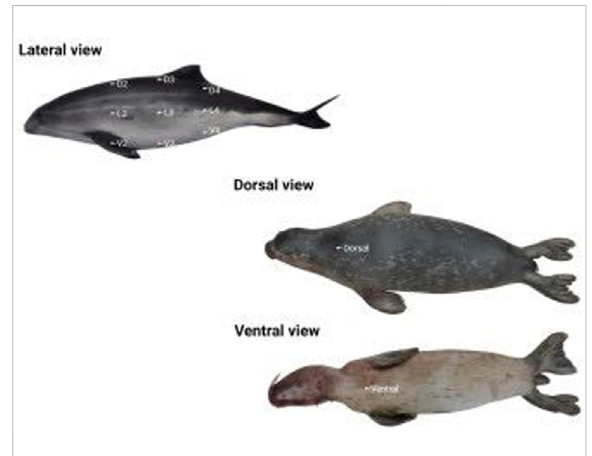
FIGURE 1 Locations of blubber thickness measurements: Lateral view for a harbor porpoise ( Phocoena ; D2, L2 and V2: cranially to the pectoral fi n; D3, L3 and V3; D4, L4 and V4: caudally to the dorsal fi n) and dorsal and ventral views dorsal blubber thickness measurement in a seal.